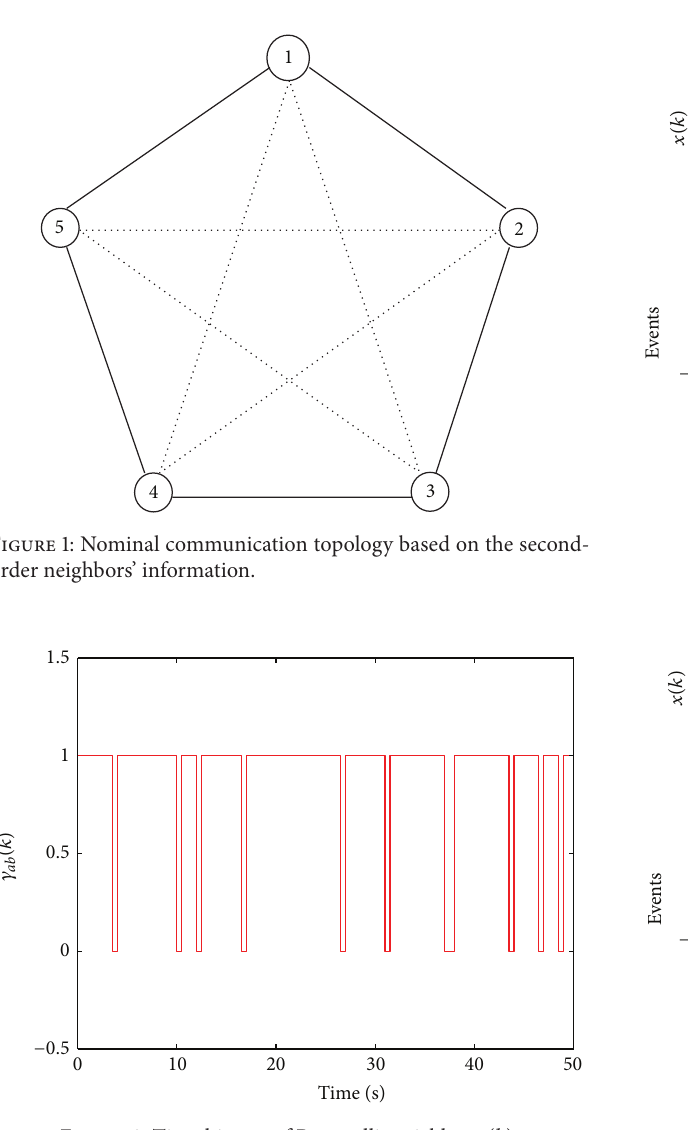
Figure 2: Time history of Bernoulli variable 𝛾 𝑎𝑏 (𝑘) .